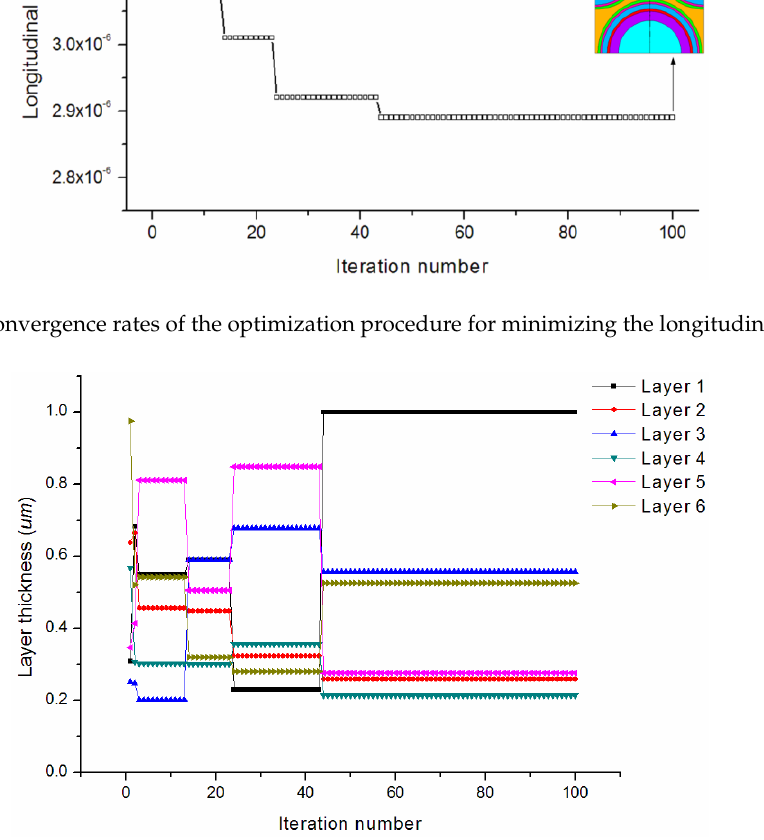
Figure 7. Convergence of the design variables for minimizing the longitudinal CTE.